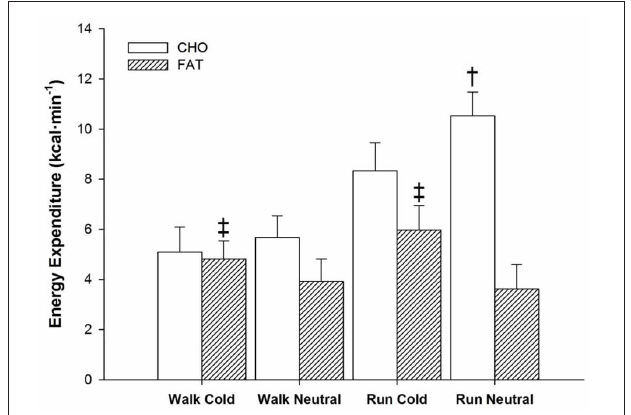
FIGURE 3 | Energy expenditure from CHO and fat sources for the entire 60min of exercise during walking and running, in both cold and neutral ambient temperatures. ‡ Fat greater in cold compared to neutral across exercise ( P < 0 . 05). Mean ( ± SD). † CHO greater in Neutral compared to Cold trials ( P < 0 .